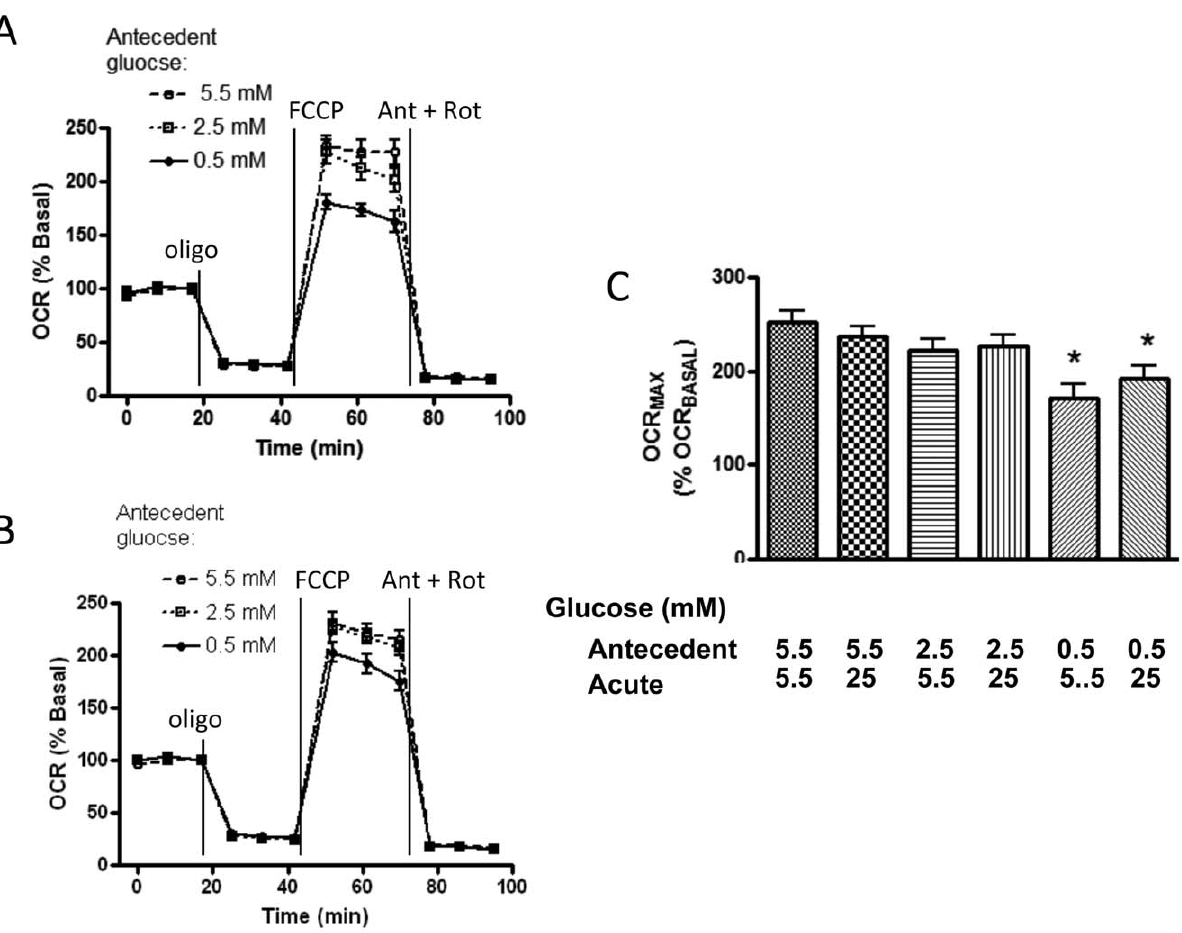
Figure 3. Effect of antecedent low glucose on mitochondrial bioenergetics in BAE cells. A) Mitochondrial function was assessed after 18 h exposure to 5.5, 2.5, or 0.5 mM glucose followed by acute exposure to 5.5 mM glucose. Data are expressed as percent basal (relative to the last basal data point just prior to addition of oligomycin) and represent mean 6 SEM values determined in 12–16 wells. B) Mitochondrial function assessed after 18 h exposure to 5.5, 2.5, or 0.5 mM glucose followed by acute exposure to 25 mM glucose. Data points and injected compounds are as in panel A. C) Quantitative data comparing OCR on FCCP as a function of basal OCR in cells previously and then acutely exposed to the glucose concentrations indicated. Values represent mean 6 SEM values over 9–12 wells, * p , 0.05 ** p , 0.01 compared to antecedent 5.5, acute